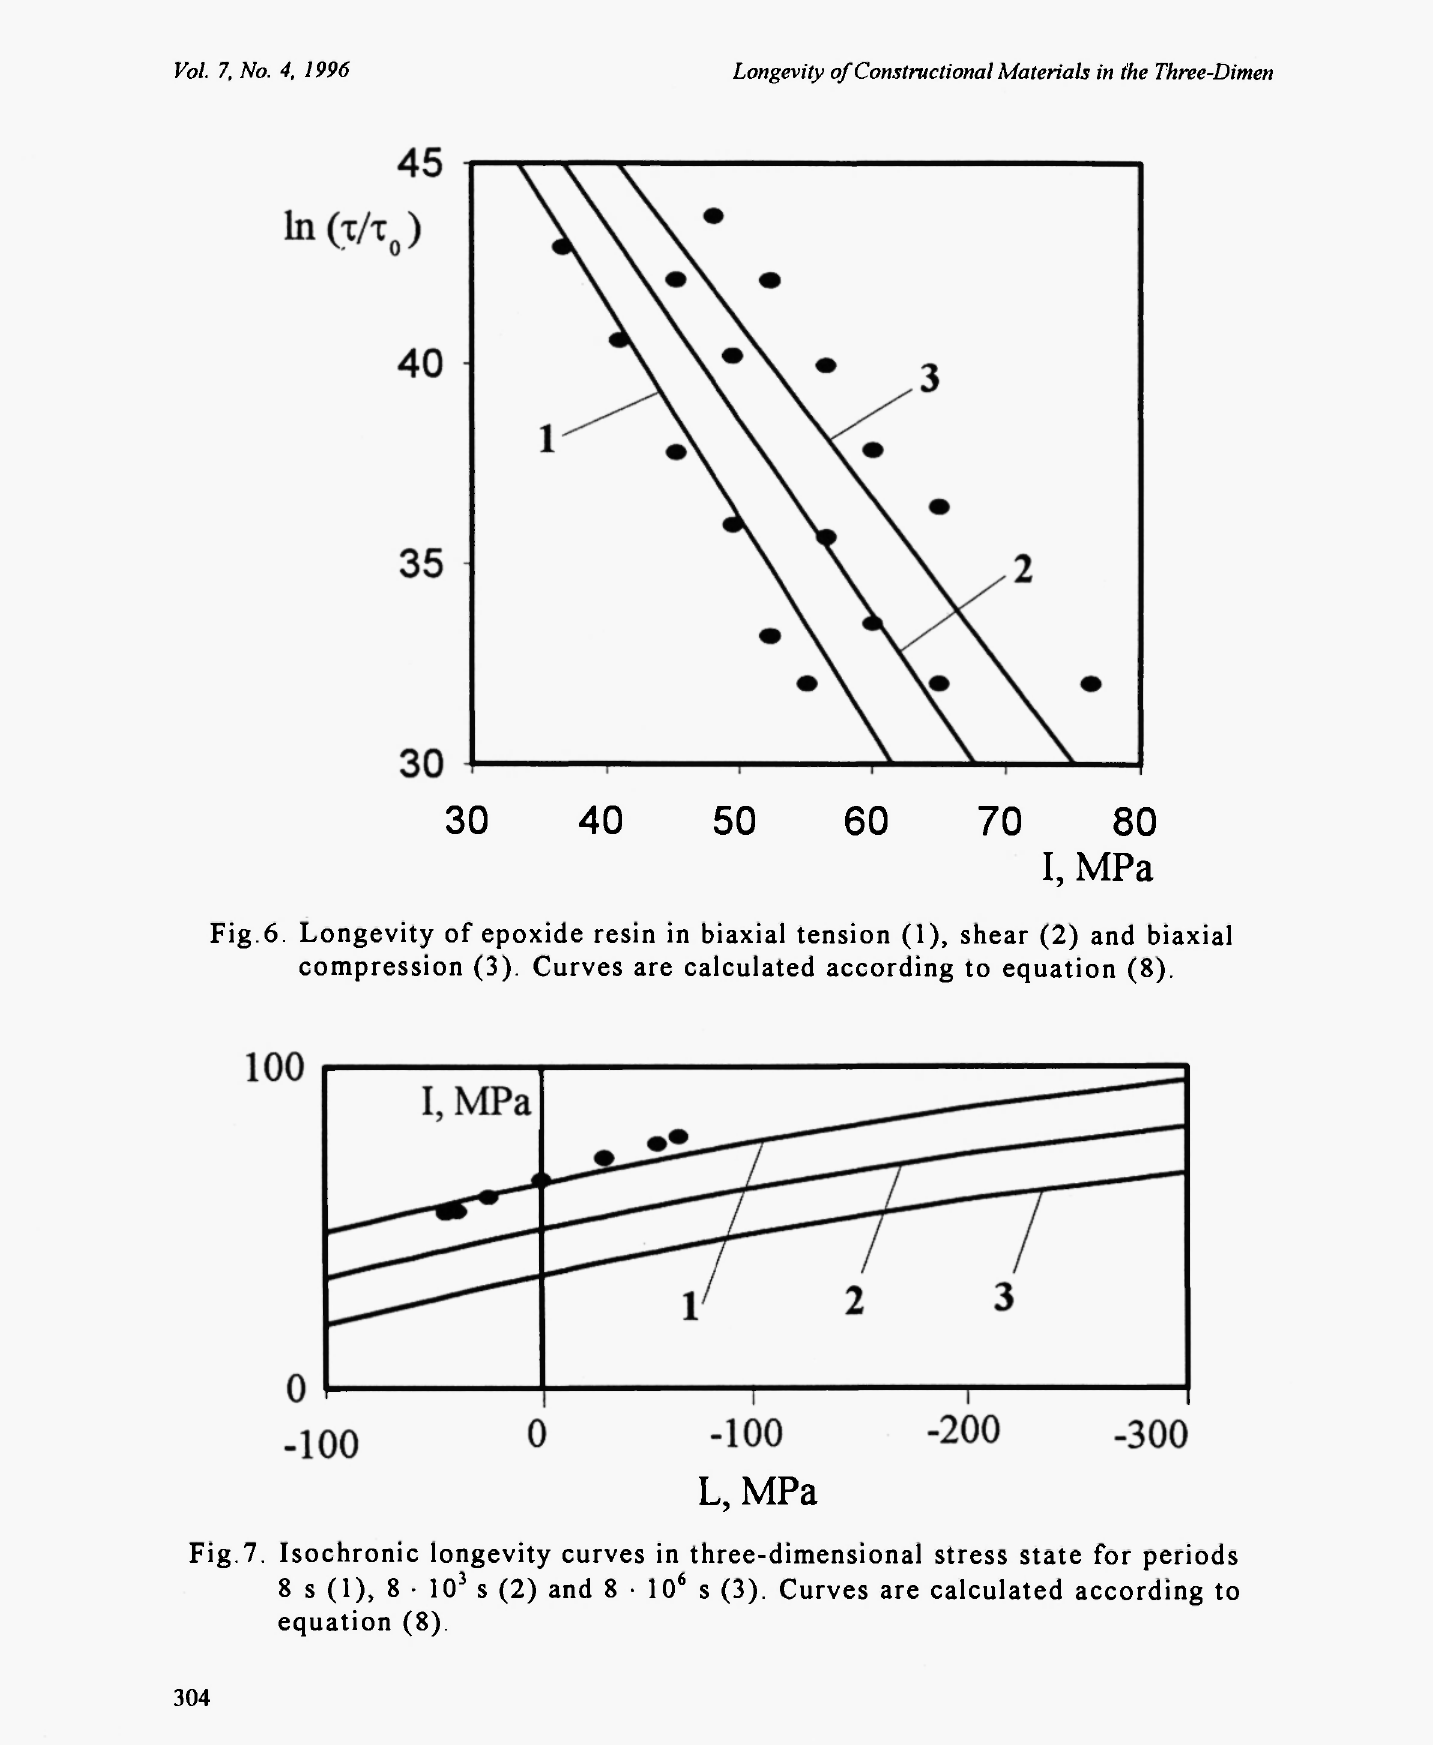
Fig.7. Isochronic longevity curves in three-dimensional stress state for periods 8 s (1), 8 · 10 3 s (2) and 8 · 10 6 s (3). Curves are calculated according to equation